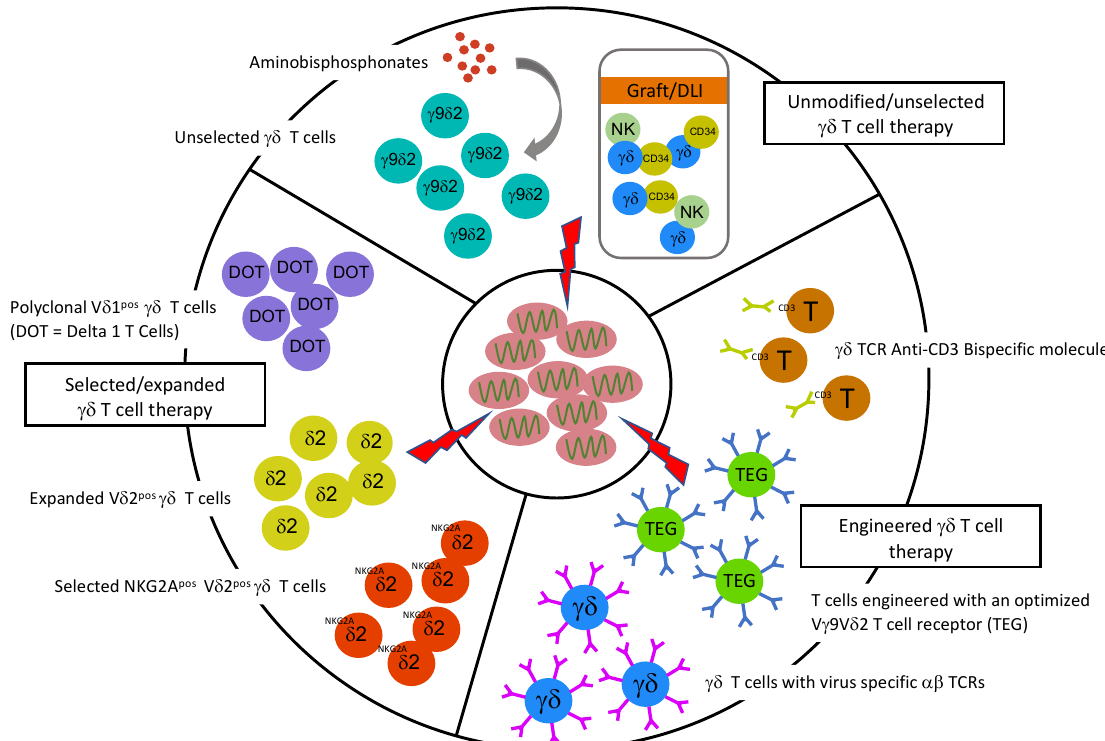
Figure 1. Possible γδ T cell-mediated therapies in viral infections.